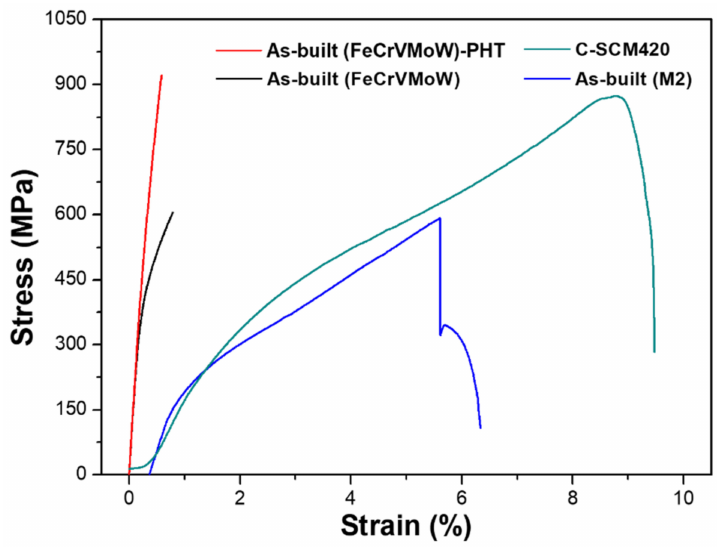
Figure 15. Engineering stress-strain curve of each